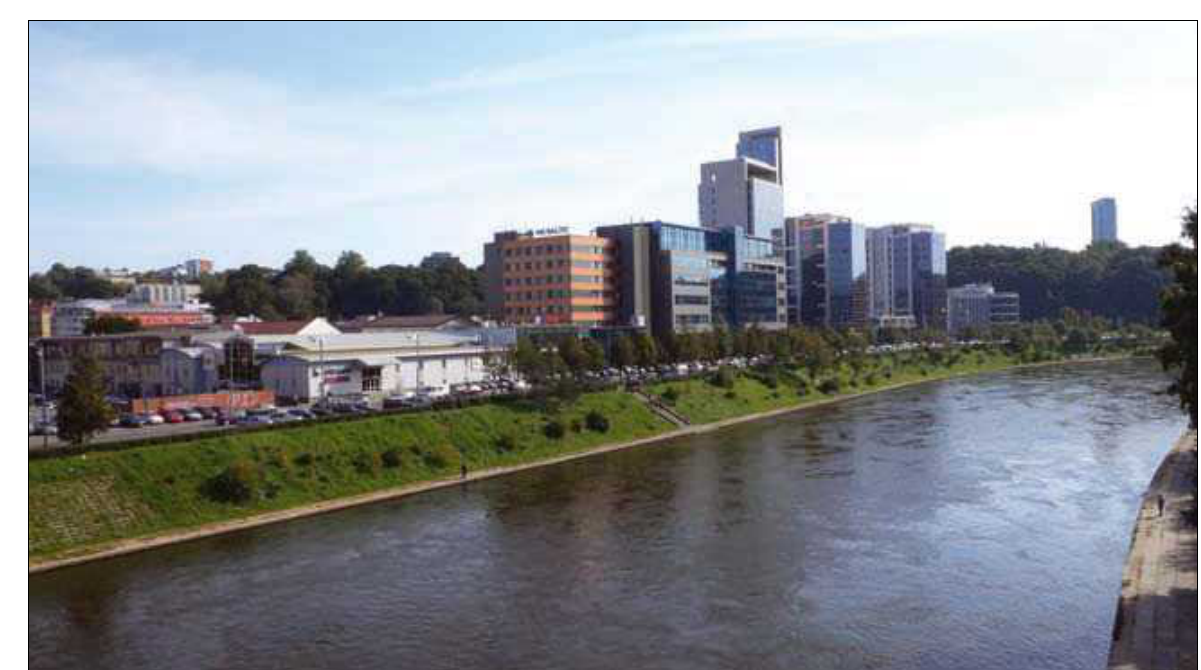
Fig. 1. ter­r­itor­y called “bu­siness tr­iangle“ in